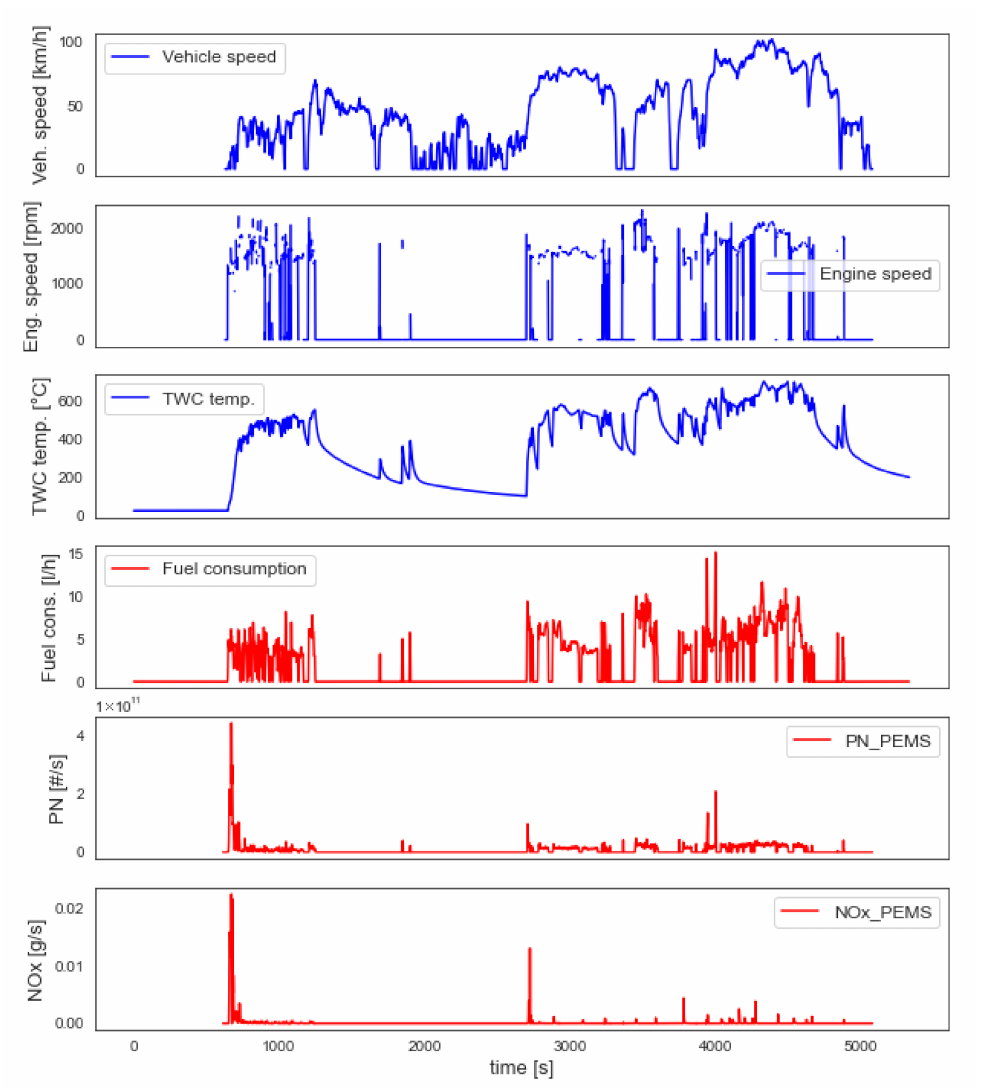
Figure 3. Overview of the main measured values for an exemplary real-world test drive in the Stuttgart metropolitan